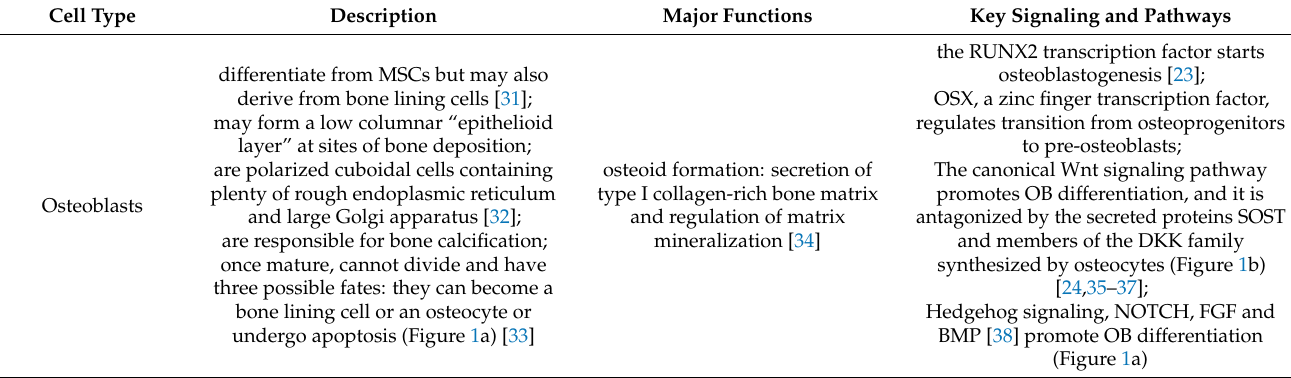
Table 1. Functions and cell signaling of specialized bone cells involved in the bone remodeling process. Cell Type Key Signaling and